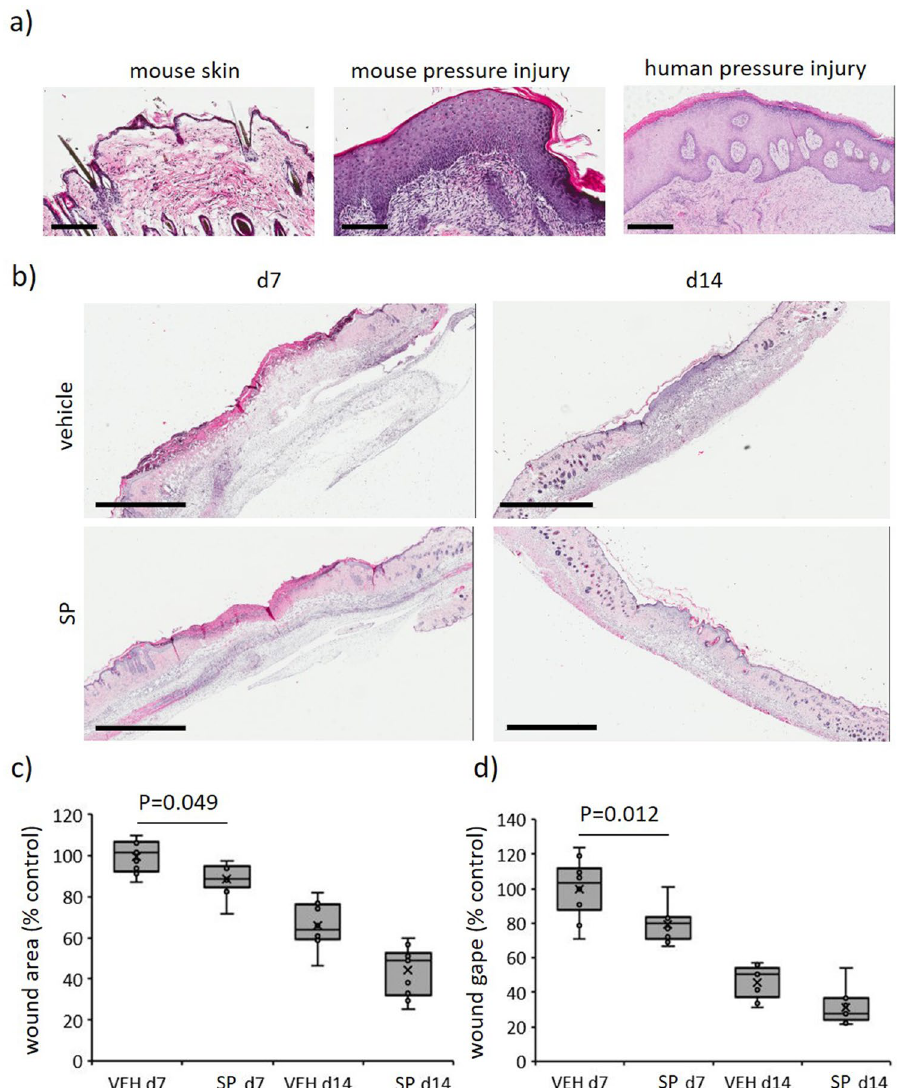
Figure 3. SP improves wound healing in I/R-mediated pressure injury. ( a ) Representative H&E images of mouse and human pressure injury tissue. Scale bars = 200 µm (mouse pressure injury and control at d14) and 500 µm (human pressure injury, stage 3, 66-year-old). ( b ) Representative H&E images of SP-treated mouse pressure injuries at d7 and d14. Scale bars = 2 mm. Wound area ( c ) and gape ( d ) quantified from H&E stained tissue. Presented as box and whisker plot, n = 6. Data analyzed by two-way ANOVA with Bonferonni post-hoc